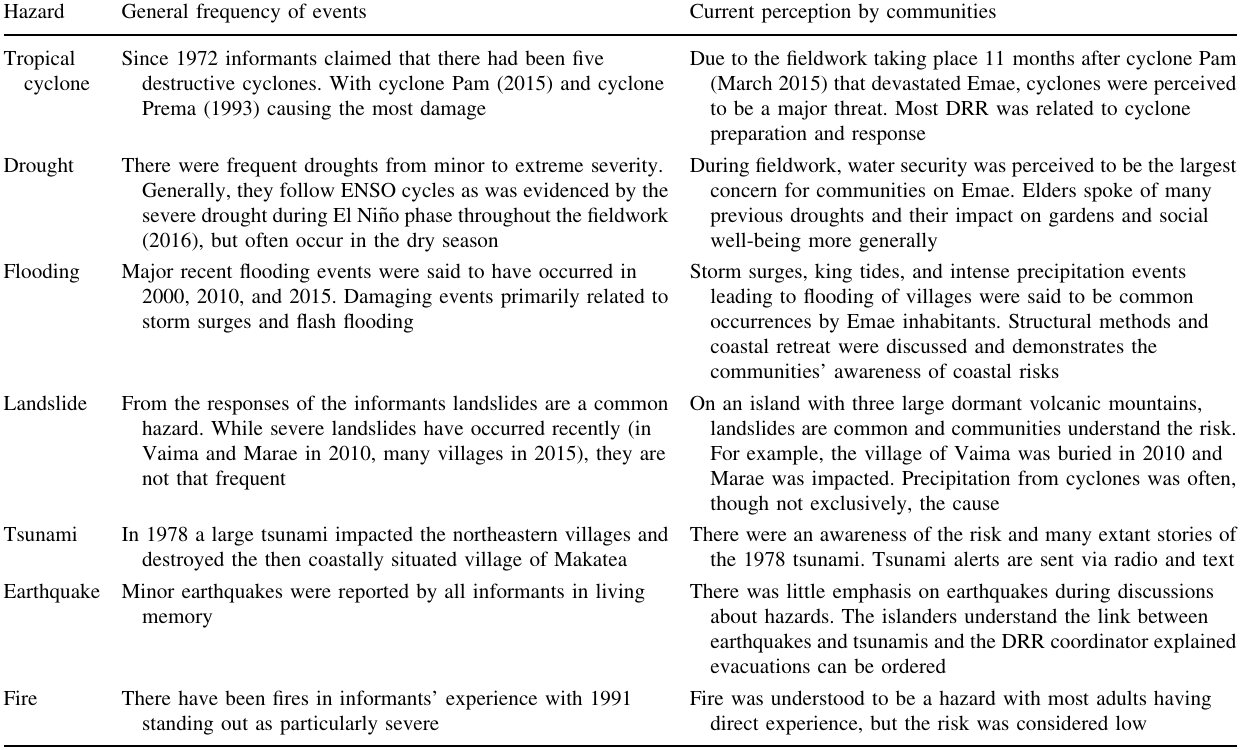
Table 1 Emae community perceptions of hazard exposure Hazard General frequency of events Current perception by communities Tropical